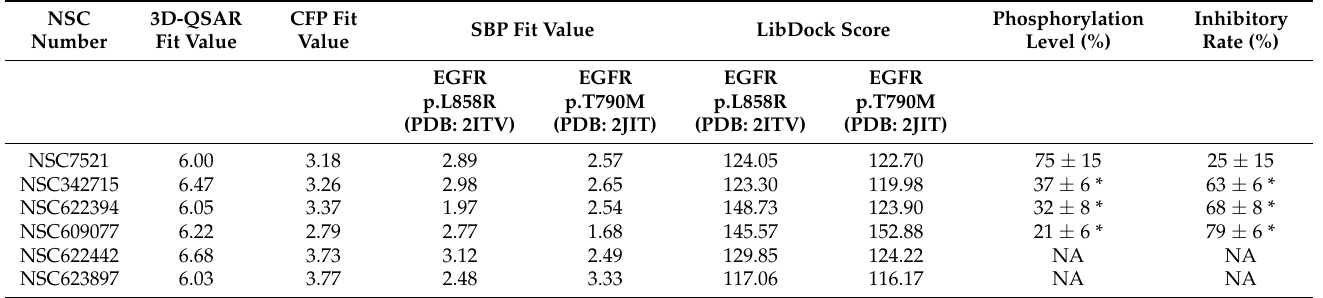
Table 4. The pharmacophore-derived fit values, docking scores, and the suppression effects of the candidate compounds on EGFR phosphorylation at